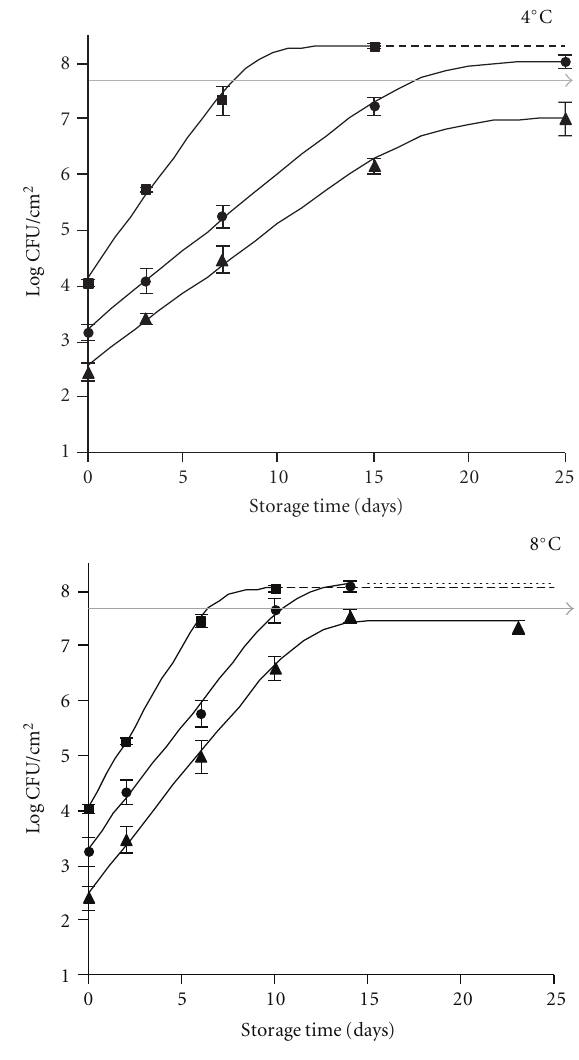
Figure 1: Changes in the total viable counts of marinated pork loin slices subjected to E-beam treatment and stored at 4 ◦ C and 8 ◦